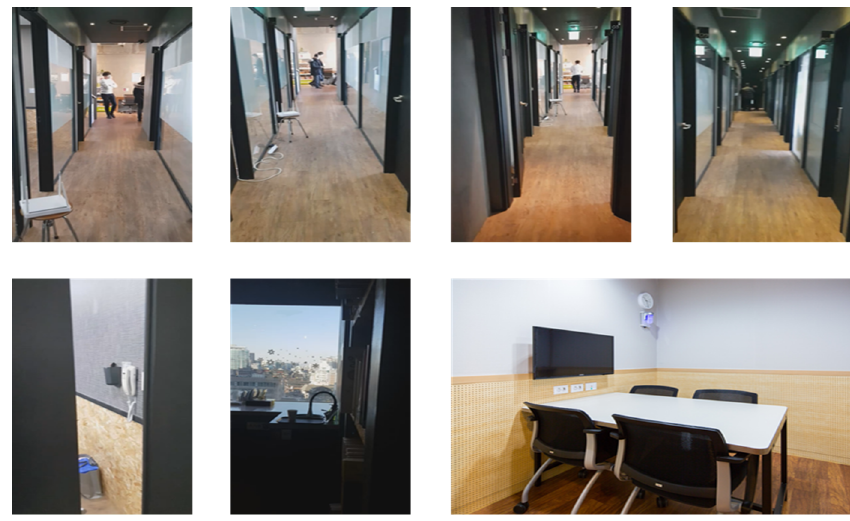
Figure 11. Indoor environment for the experiments (meeting room).